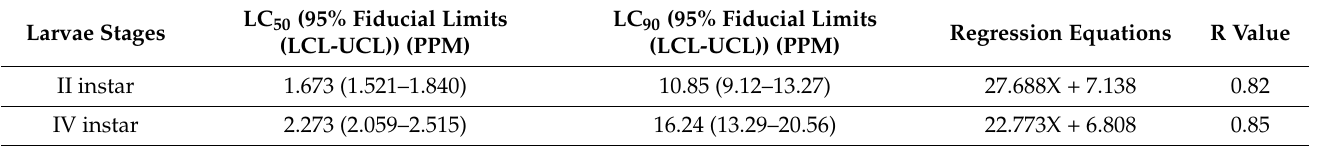
Figure 12. Larvicidal activity of PoAgNPs. Mean ± SE followed by different letters were significantly different (Tukey’s test, p < 0.05). Table 3. LC 50 and LC 90 values of PoAgNPs against Culex mosquito at different stages.